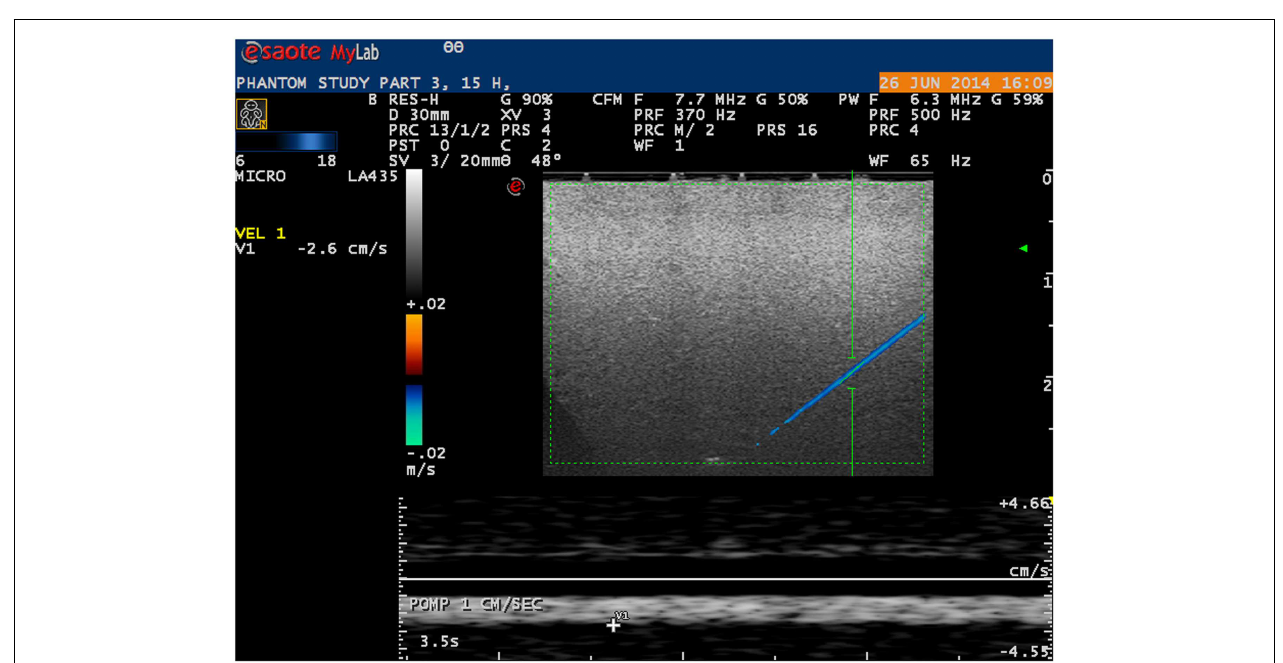
FIGURE 2 | Ultrasound image of phantom microvessel . Ultrasound image showing a 200 µ m flow phantom catheter as depicted by a linear probe in color Doppler mode.